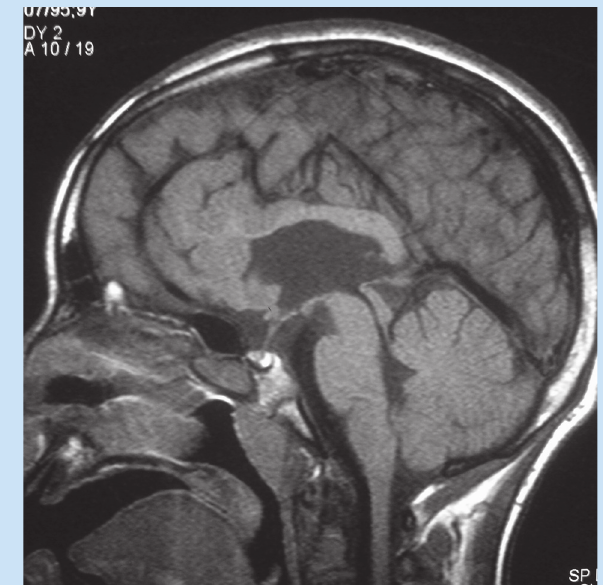
Fig. 2. Defective development (dysgenesis) of the corpus callosum in a patient with lobar